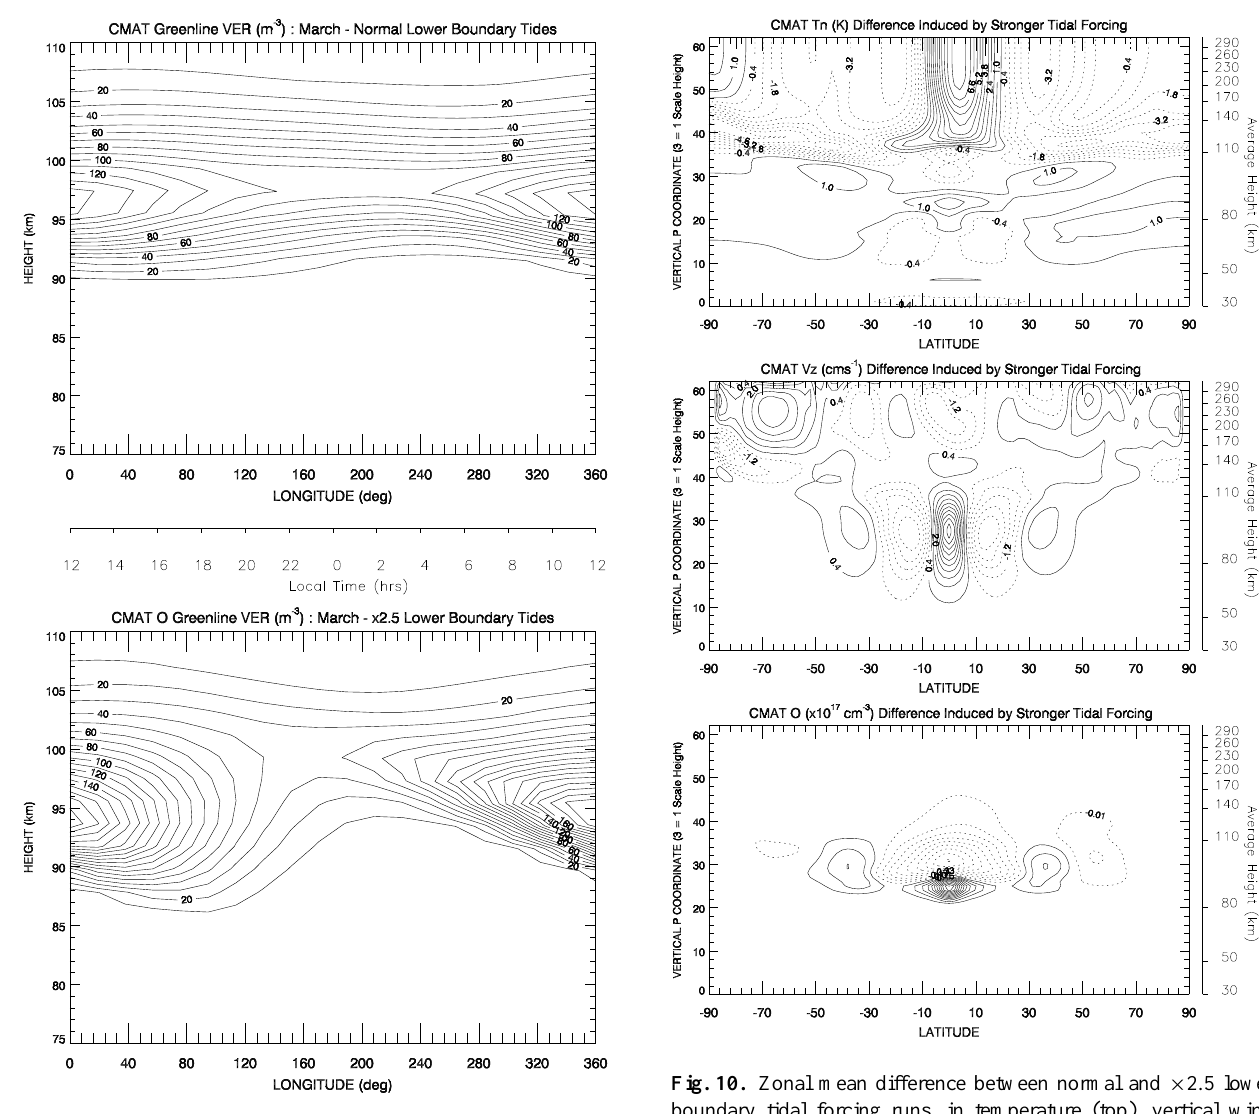
Fig. 10. Zonal mean difference between normal and × 2 . 5 lower boundary tidal forcing runs, in temperature (top), vertical wind (middle, positive values denote increase in upward winds), and atomic oxygen